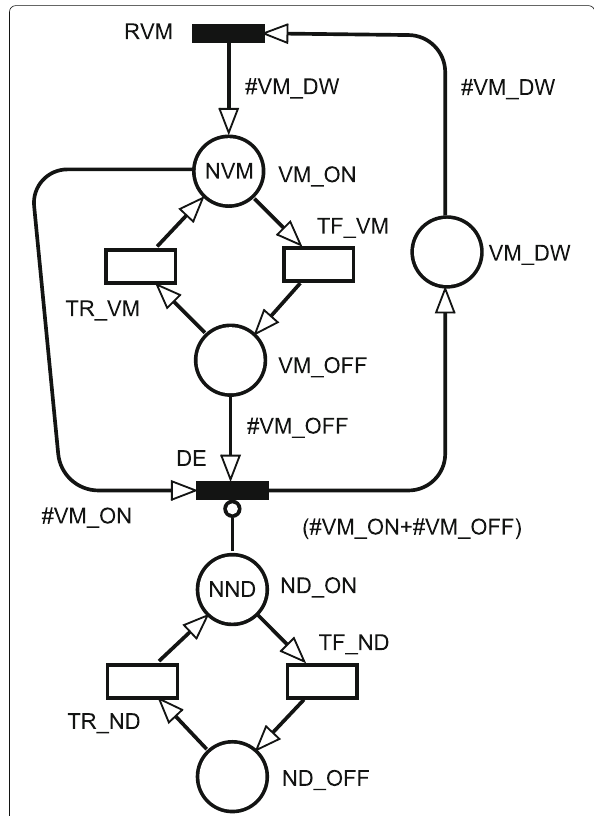
Fig. 6 An illustrative example of a SPN model for active-active (A/A)